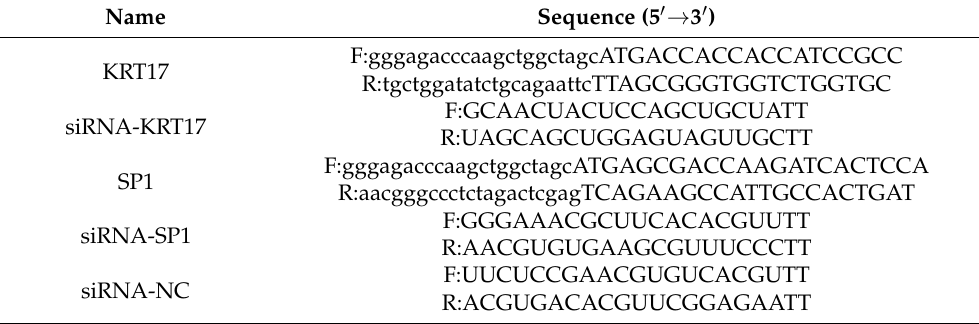
Table 11. Primers for KRT17 and SP1 cloning and RNAi.